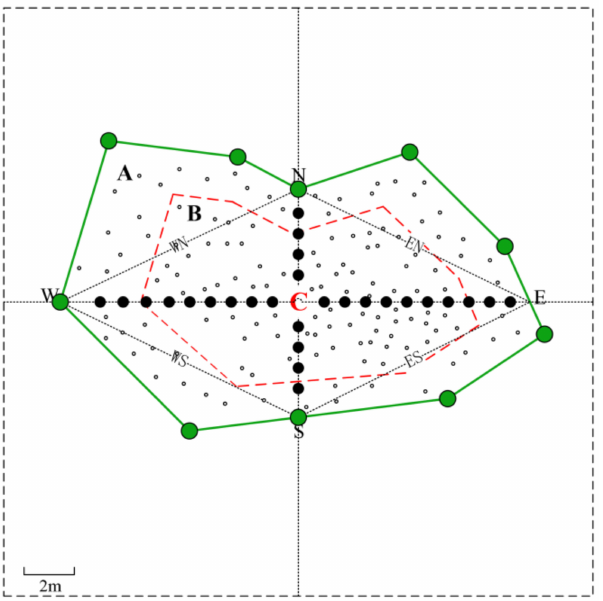
Figure 1. Sketch of regeneration individual plot distribution within a large, expanded forest gap. : Gap border trees : Regeneration individual in L. principis-rupprechtii plantations : Acquisition points for hemispherical photographs. Abbreviations: A, expanded gap: crown projection of border trees. B, canopy gap: vertical projection of the canopy opening. C = center point of the gap; N = northern transition; E = eastern transition; S = southern transition; W = western transition; NE = northeast; SE = southeast; NW = northwest; SW =